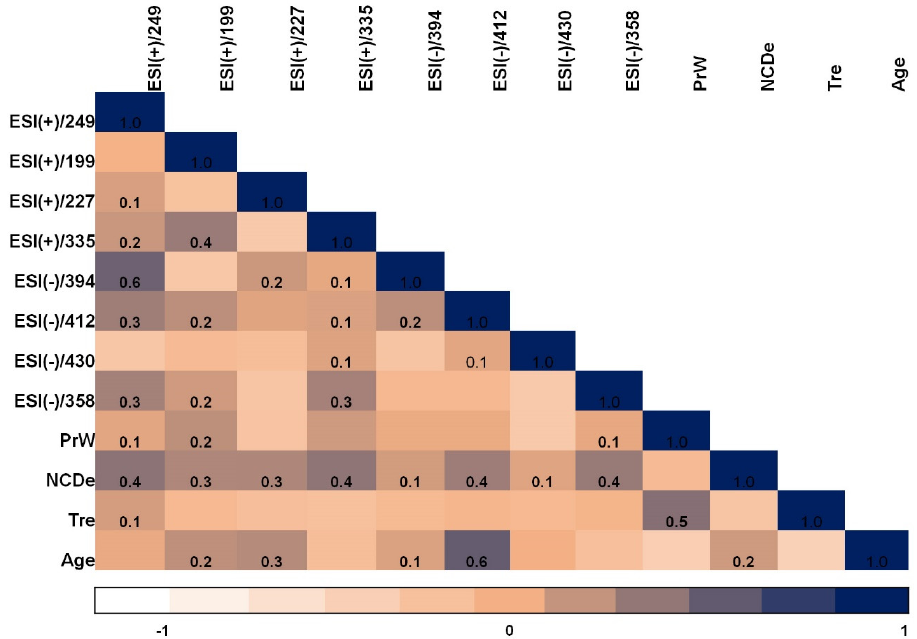
Figure 5. Pearson correlation matrix illustrating the significance between investigated variables. PrW (pregnancy week), NCDe (the number of detected compounds), Tre (test results) .